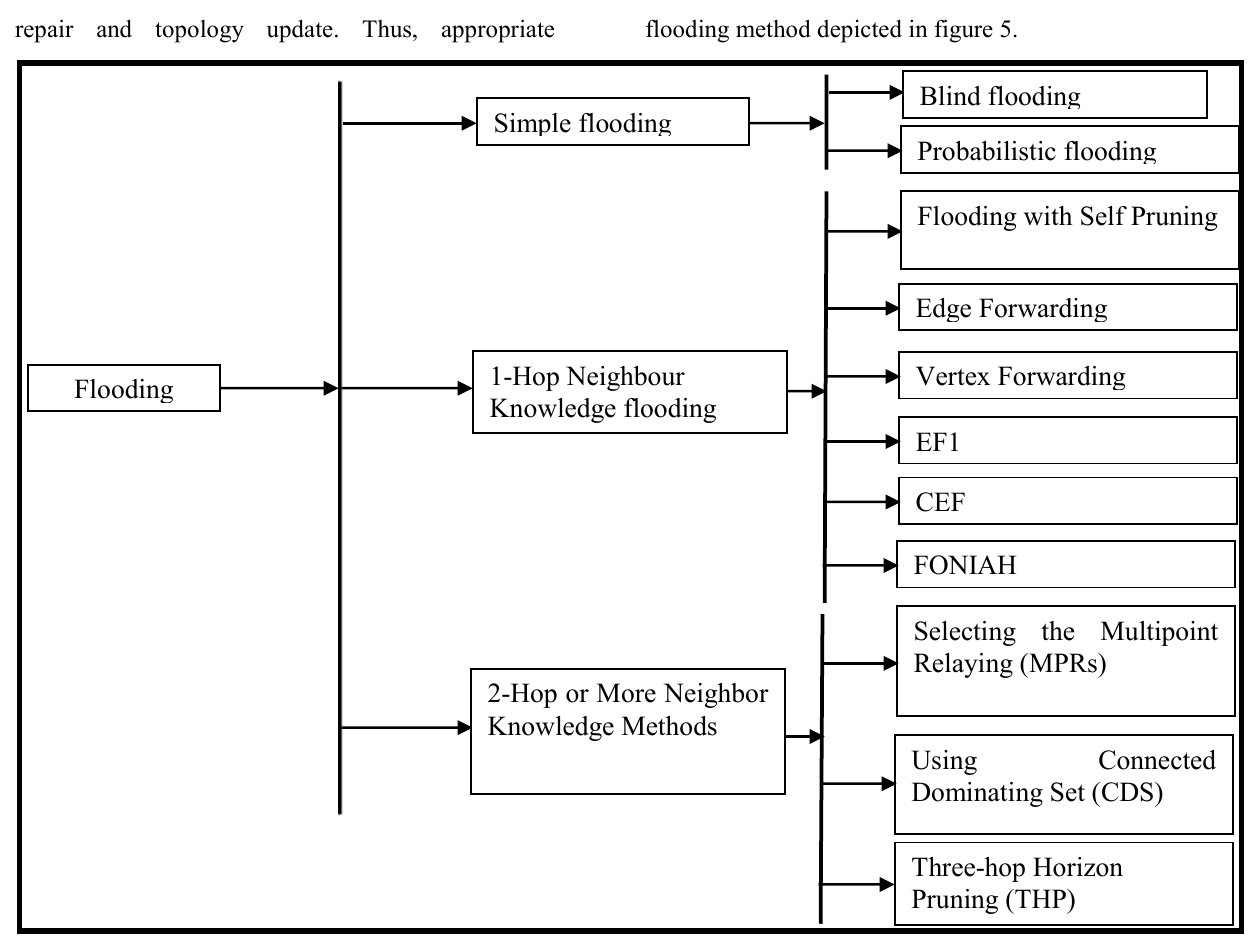
Figure 5. Various category of